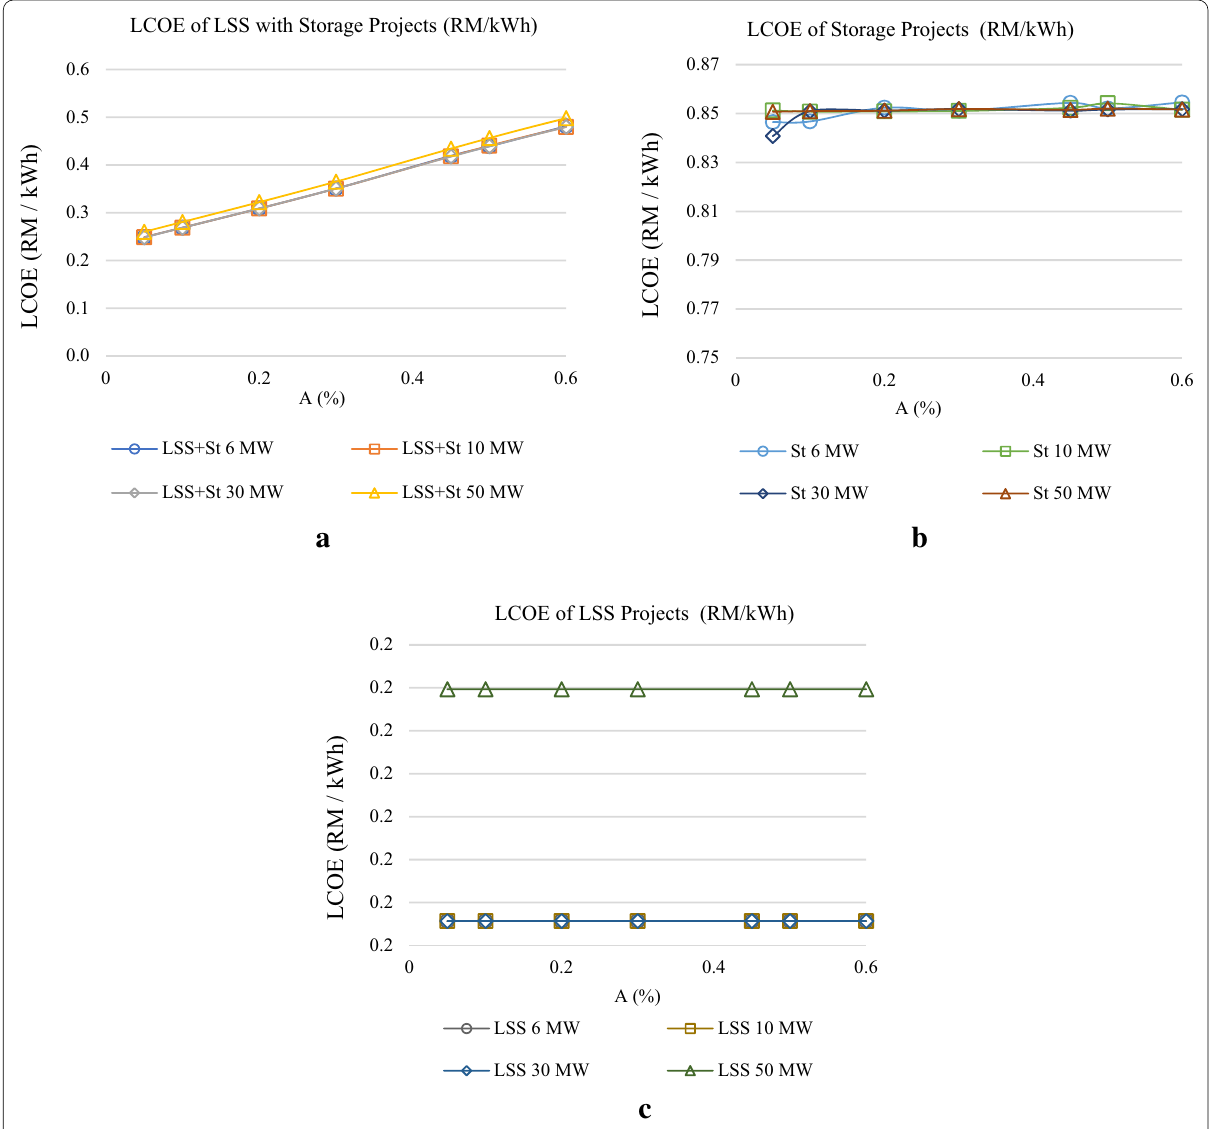
Fig. 7 Levelized cost of electricity of different LSS capacities with variation of “ A ”. a LSS with storage projects, b storage projects, c LSS